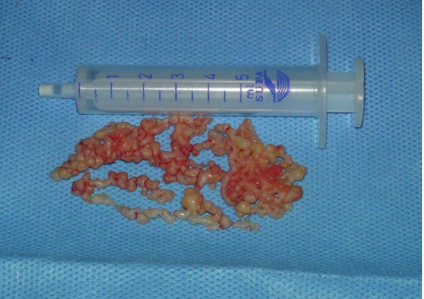
Figure 3: Gross specimen of papillary fibroelastoma demonstrating two large beading